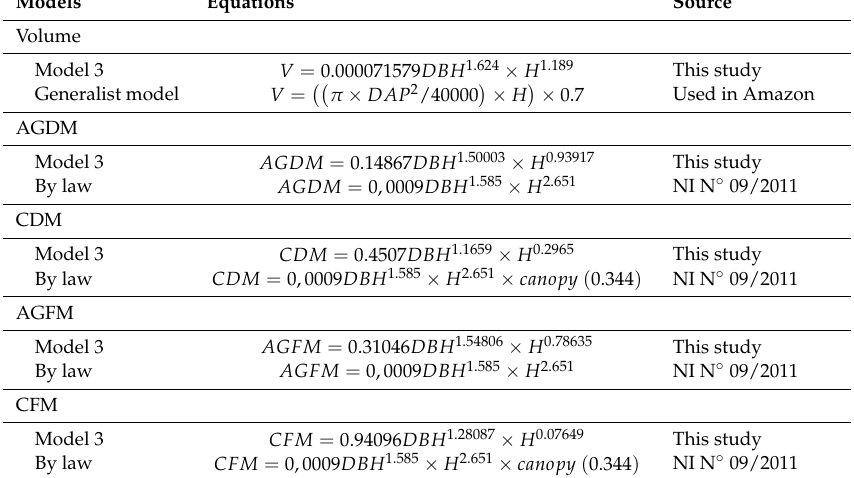
Table 4. Allometric models developed for rosewood commercial plantations at different tree sample-plots for estimating volume tree (V—m 3 per tree), above-ground dry mass (AGDM; kg per tree), above-ground fresh mass (AGFM; kg per tree), crown dry mass (CDM; kg per tree), and crown fresh mass (CFM; kg per tree) with stem diameter at breast height DBH (cm) and height (m) in contrast with allometric models used in Amazon for estimating volume and equations by normative instruction (NI) for estimating rosewood biomass. The allometric equations were developed on the basis of two regions from Central Amazonia with 108 trees for volume and total weight and 144 trees for crown mass.